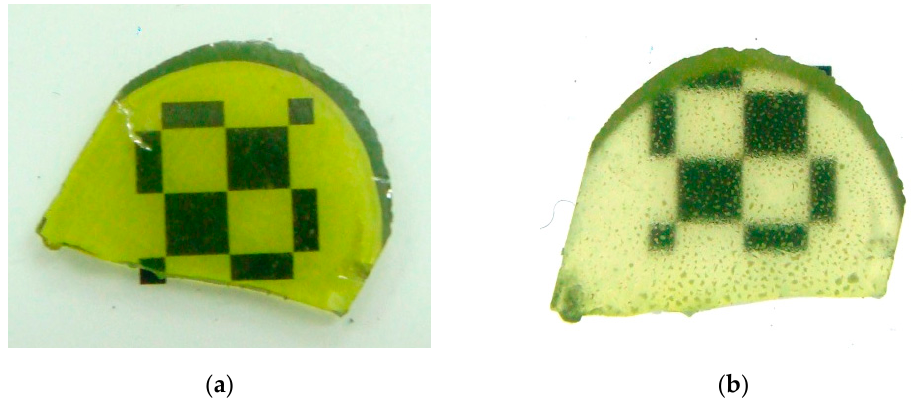
Figure 1. CeAlO 3 single crystalline samples before ( a ) and after ( b ) annealing at 1700 °C in the Ar and CO reducing atmosphere.